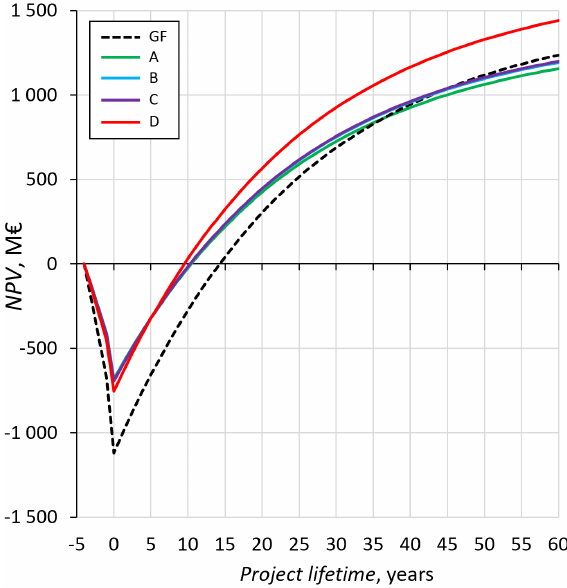
Figure 18. NPV as a function of project lifetime for steam cycle modernization cost index MC ST = 0.5 for average level of RS.